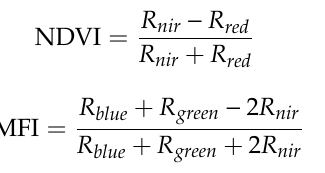
represent the reflectance of the red band, blue band, green band, and near infrared band, respectively. 2.4. Accuracy Validation After classification, majority analysis was implemented, and further editing was performed to eliminate obvious errors. In addition, the accuracy of the classification results was further validated. To measure the quality of the classification, accuracy measures were used in this study. Generally, these measures were based on comparing a classification result with a reference classification obtained via a different method, e.g., on-site ground measurements, which are considered reliable and true. A confusion matrix that contains all the information about the relation between the classification and reference classification can be derived. Then, the overall accuracy (OA), producer’s accuracy (PA), and user’s accuracy (UA) can be calculated from the confusion matrix. The OA is defined as the proportion of all reference pixels that are classified correctly (in the sense that the class assignment of the classification and of the reference classification agree). As the OA, PA, and UA give no information about what classes are classified with high accuracy and cannot reflect the agreement between the two classification sets for each class, the kappa coefficient was further used to reflect this